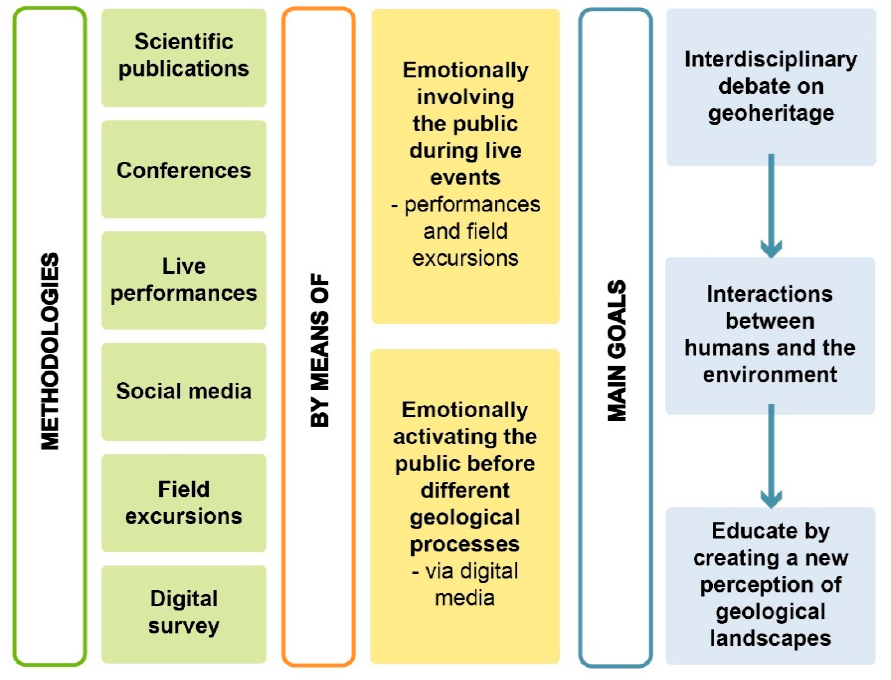
Figure 2. Methodological flow chart.